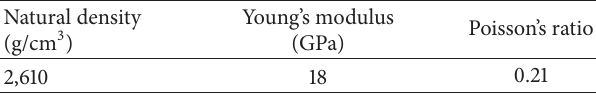
Table 1: Physicomechanical parameters of a typical rock